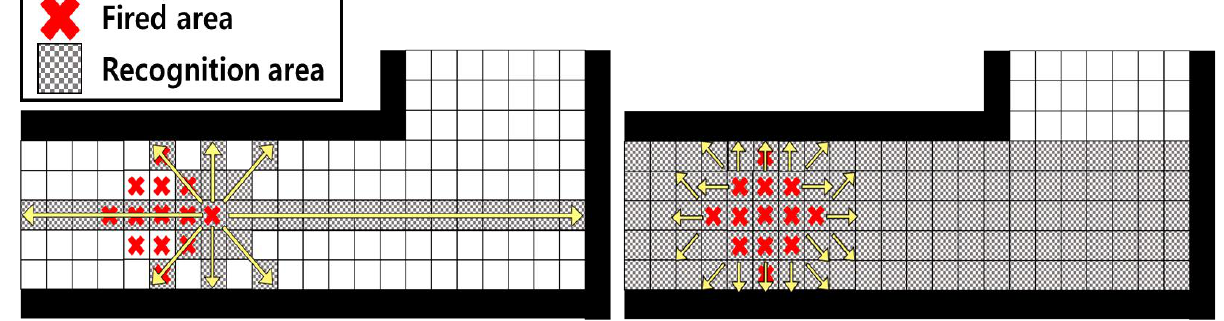
Figure 6. A process of fire recognition field computation